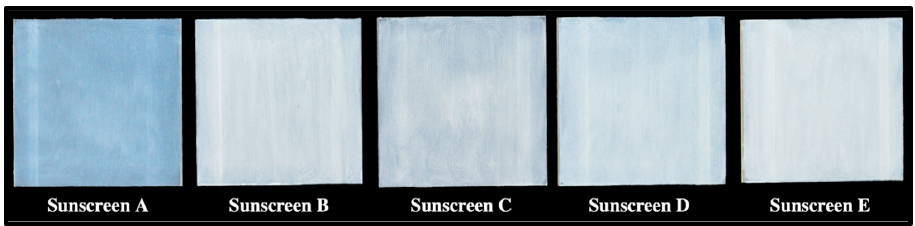
Figure 9. Order of transparency: A < C < B ≤ D < E.